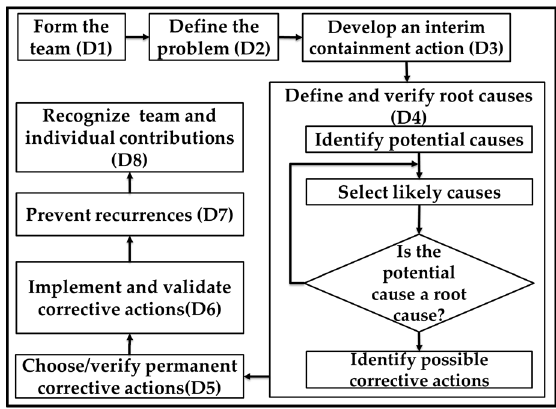
Figure 2. Steps for the 8Ds problem-solving process. Adapted from Joshuva and Pinto [35].